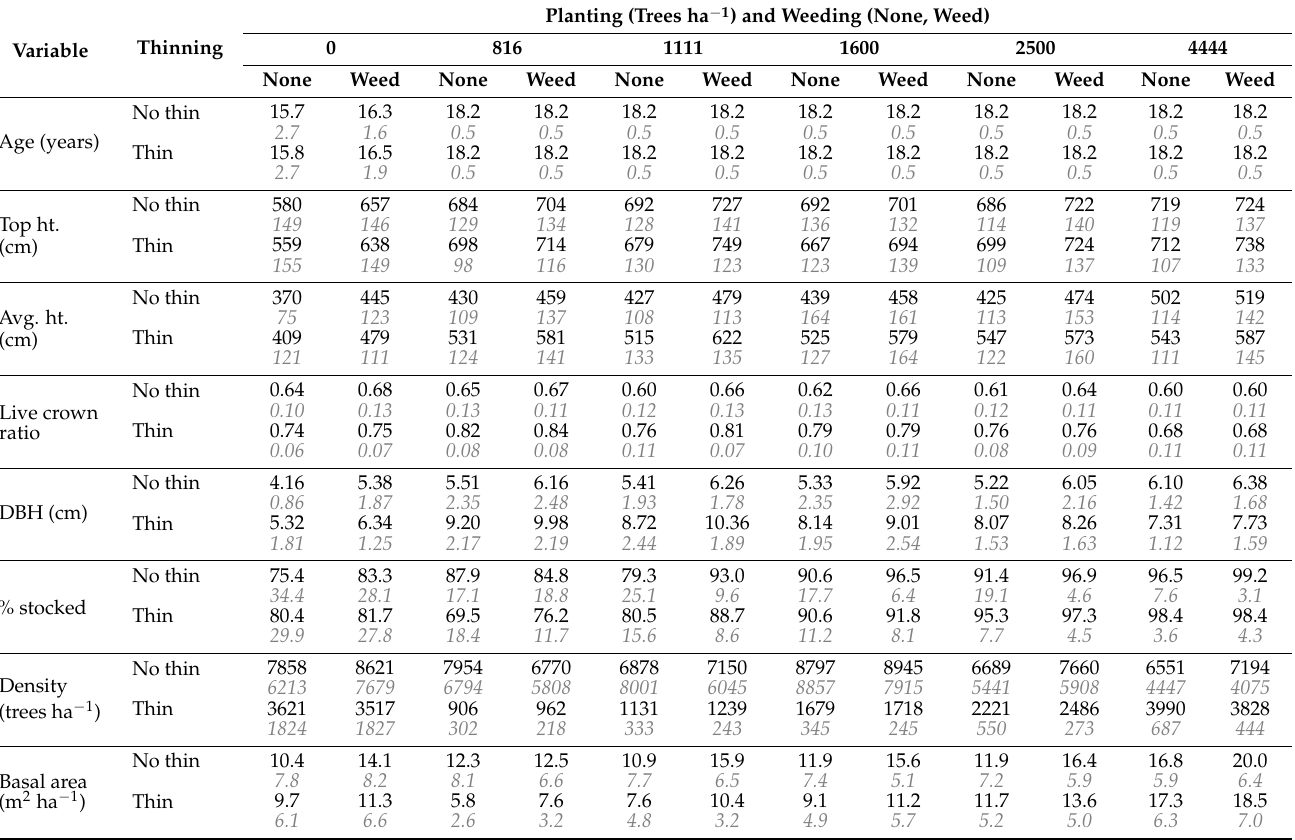
Table 1. Stand variables 17 growing seasons after planting: means and standard deviations.